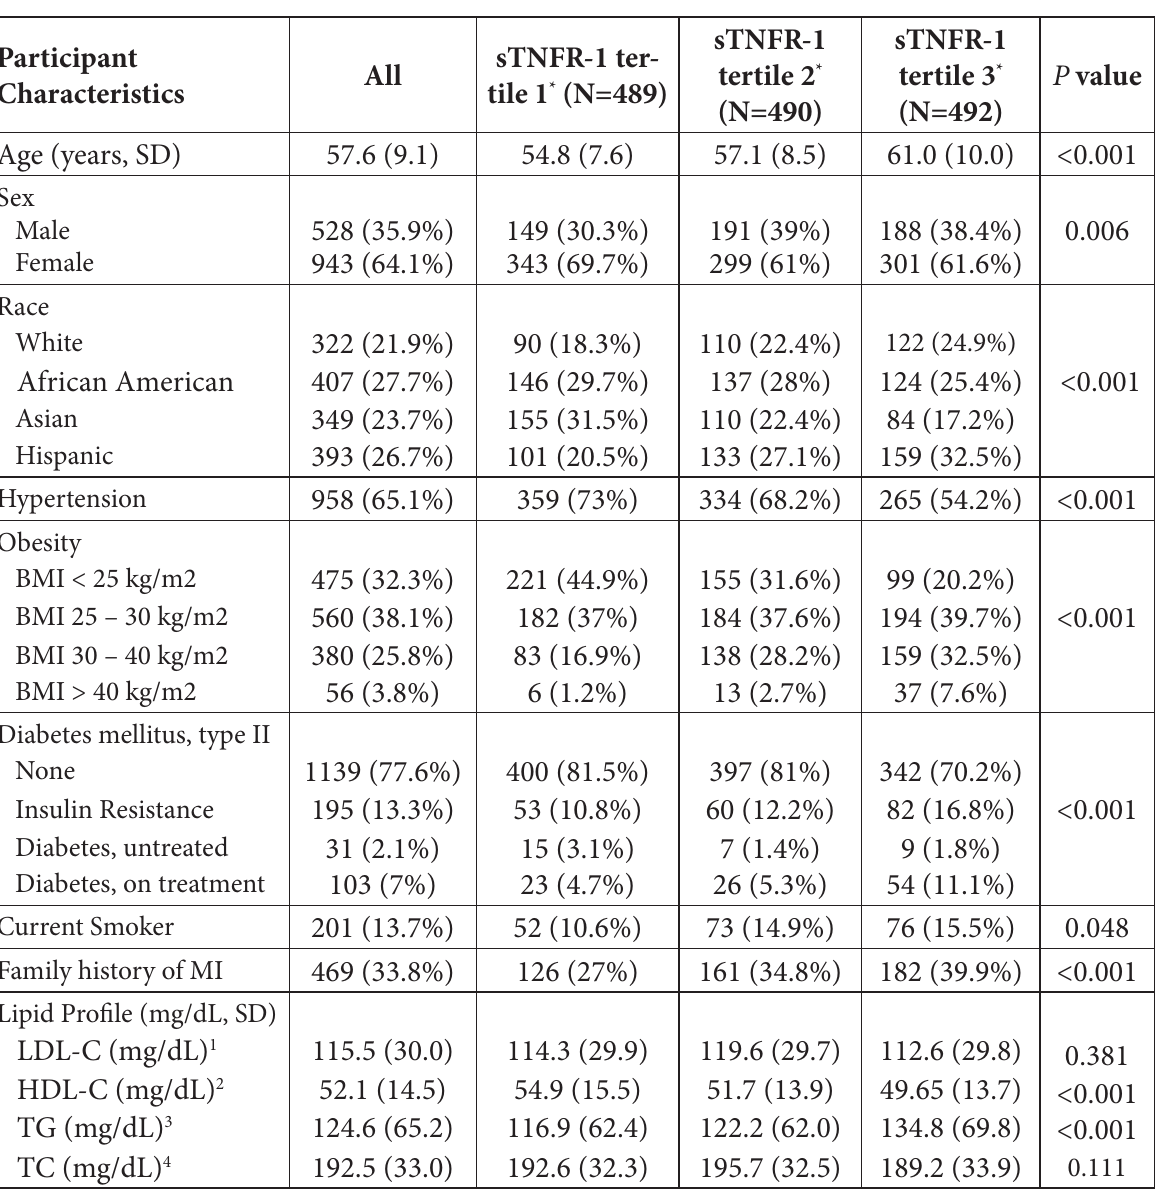
Table 1. Participant characteristics by sTNFR-1 tertiles